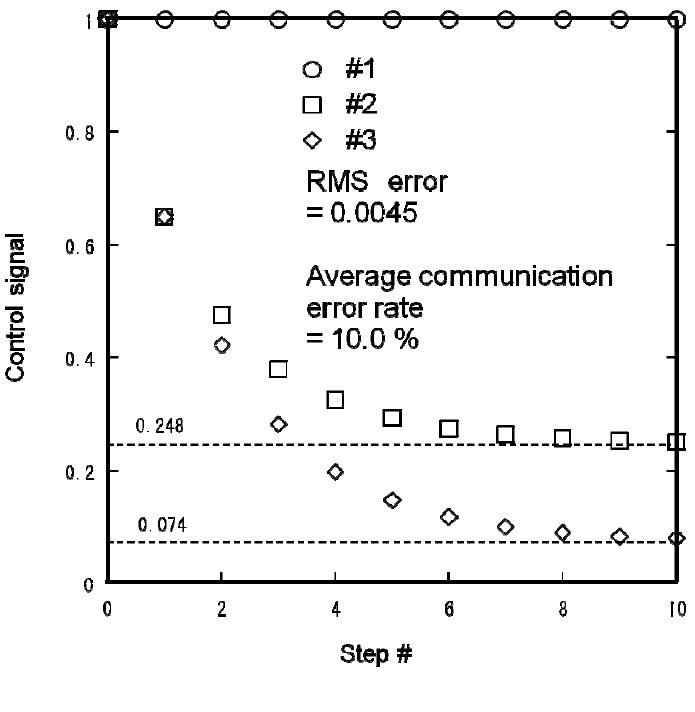
Figure 14. Experimental distributed lighting result obtained using Mote testbed for { s , s , s } = 1 2 3